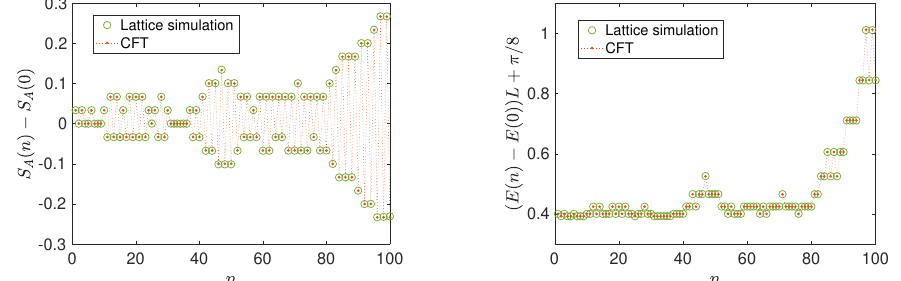
Figure 17: Comparison of the entanglement entropy (left) and the total energy evolu- tion (right) at the type I exceptional point in lattice simulations and CFT calculations with L = 800. We consider a single randomly generated driving sequence. The two driving Hamiltonians are H and H θ = with probability p = 1 / 2 and 1 / 2. The 0 0.05 / L = T / L ( θ ) = 1 / driving times are T θ 0 eff